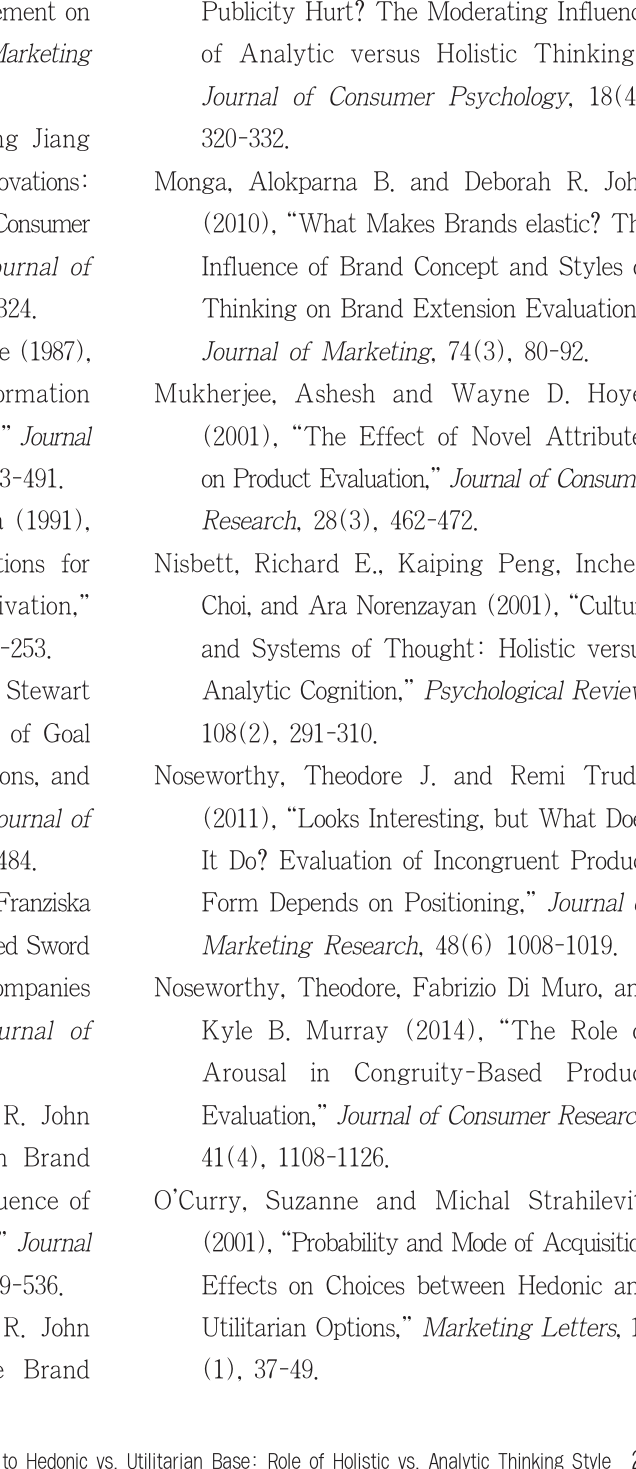
The Effect of Adding Novel Attributes to Hedonic vs. Utilitarian Base: Role of Holistic vs. Analytic Thinking Style